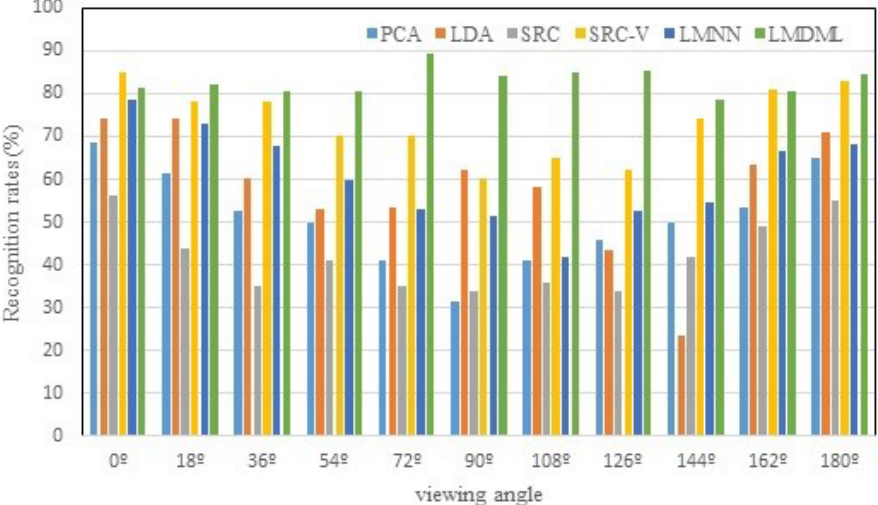
Figure 10: The recognition rates of all methods in carrying